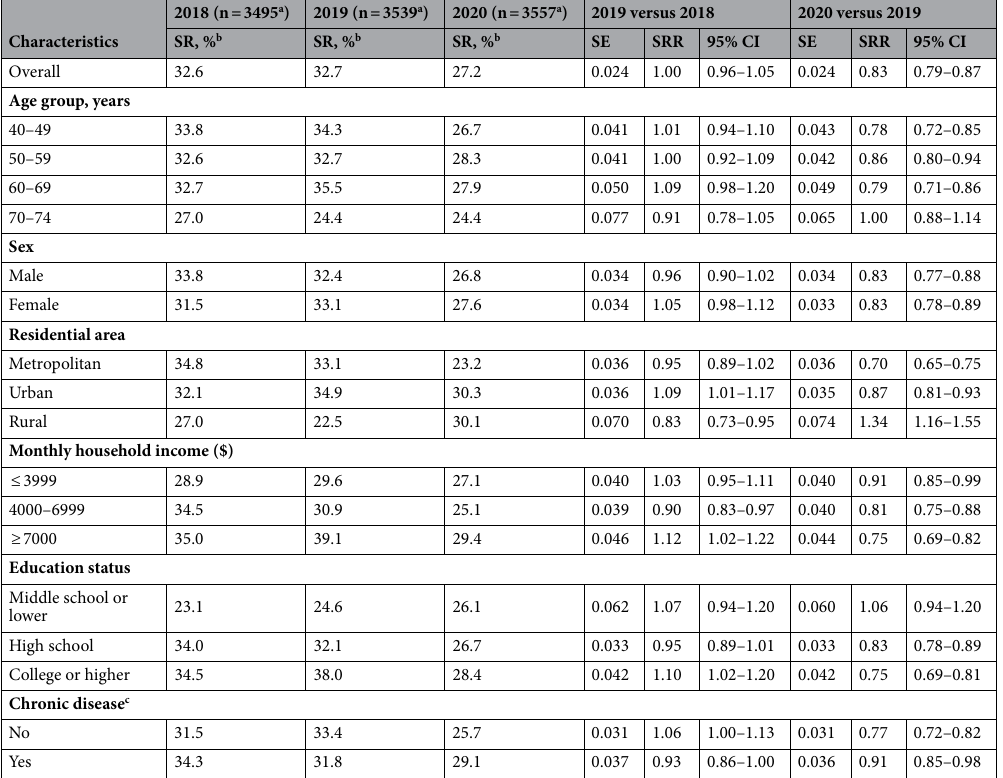
Table 1. Stomach cancer screening rates for the period 2018–2020. SR screening rate; SRR screening rate ratio; SE standard error; CI confidence interval. a The n value is the number of individuals eligible for gastric cancer screening (aged over 40 years); b SRs were defined as the proportion of screened individuals within the last 1 year; Weighting values from the Population and Housing Census were applied to calculate the SRs c Chronic disease, individuals who are diagnosed with any of following diseases: hypertension, diabetes, tuberculosis, hepatitis B, hepatitis C, liver cirrhosis, chronic gastritis, stomach/duodenal ulcers, polyps, benign breast diseases, uterine myoma, and